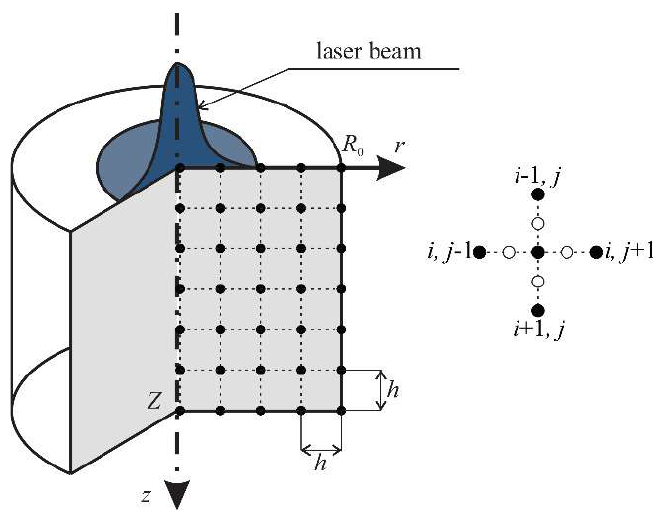
Figure 1. Differential